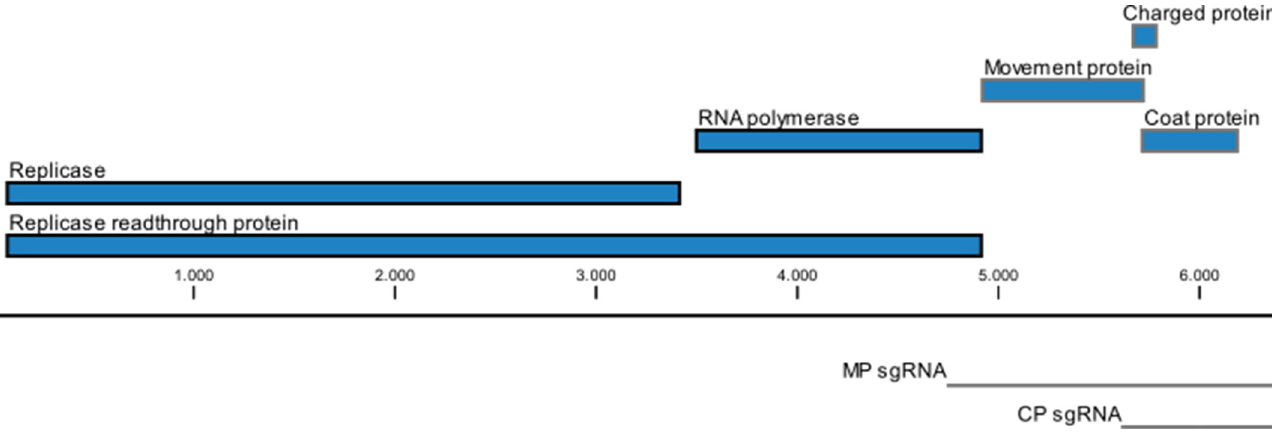
Figure 3. Schematic diagram of genome organization of TMV: ORFs encoding viral proteins are shown in blue. The 126 kDa replicase protein and the 183 kDa replicase read-through protein are translated from the genomic RNA (black), while the remaining proteins are expressed from separate subgenomic RNAs (gray). Image was modified from the NCBI Reference Sequence (NC_001367.1) [16] using CLC main workbench 21 and Inkscape 1.1.